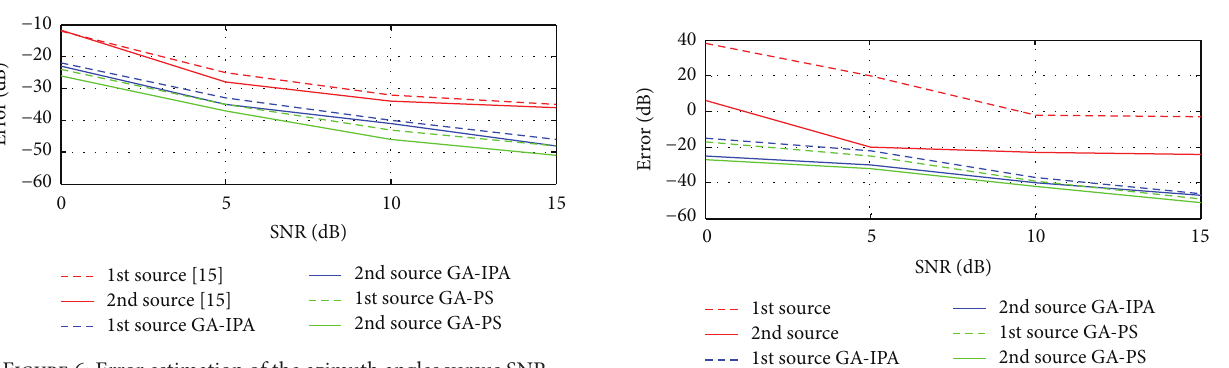
Figure 6: Error estimation of the azimuth angles versus SNR. of low SNR. The second best result is produced by the other hybrid GA-IPA scheme.